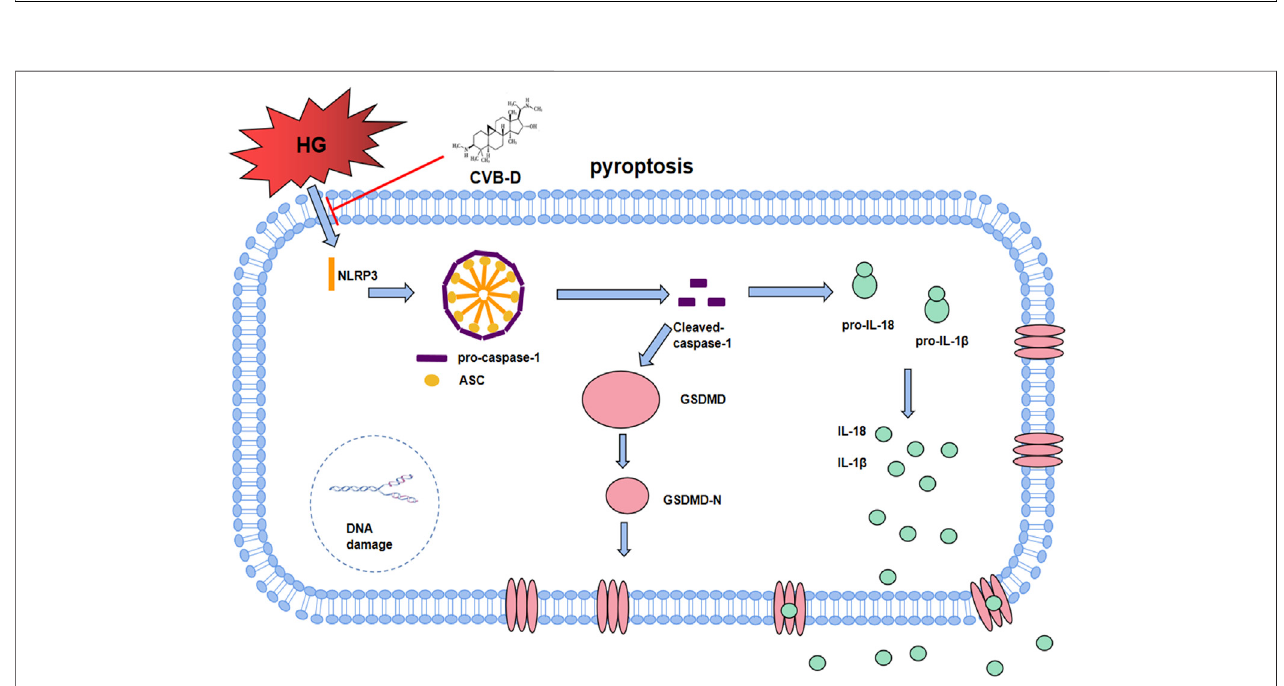
FIGURE9| ThemolecularregulationmechanismofCVB-DimprovingDCM.AfterHGinducedNLRP3overactivation,itassembleswithASCandpro-caspase-1to form in fl ammasome. After Cleaved-caspase-1 is activated, on the one hand, it activates GSDMD-N to cause pore formation on cell membrane. On the other hand, Cleaved-caspase-1 promotes the maturation and secretion of IL-18 and IL-1 β , fi nally leads to cardiomyocyte pyroptosis, accelerating the progress of DCM. CVB-D signi fi cantly ameliorates DCM, which may be associated with the inhibition of NLRP3-mediated cardiomyocyte pyroptosis.